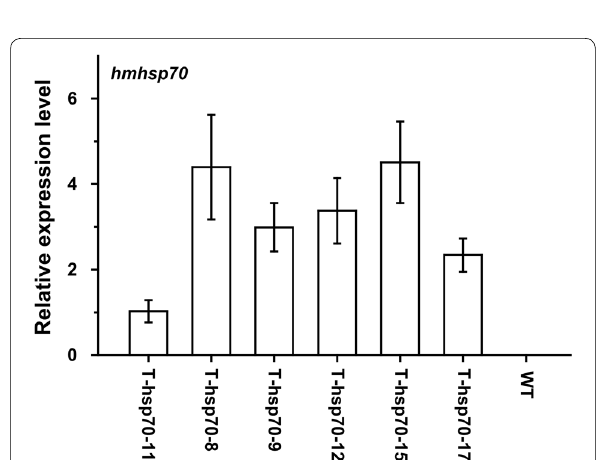
Fig. 4 Expression of hmhsp70 gene in transgenic tobaccos. The 2 − ( ΔΔCt ) values normalized to actin gene were averaged for each investigated transgenic tobaccos. The expression level of T-hsp70-11 was considered to be the reference expression